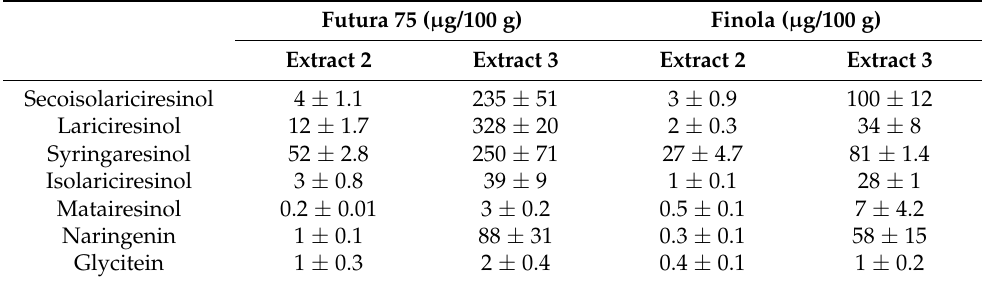
Table 1. The concentration of lignans and isoflavones in Extract 2 and Extract 3 per dry weight (DW) of Cannabis sativa L. variety Futura 75 and Finola, n = 2.